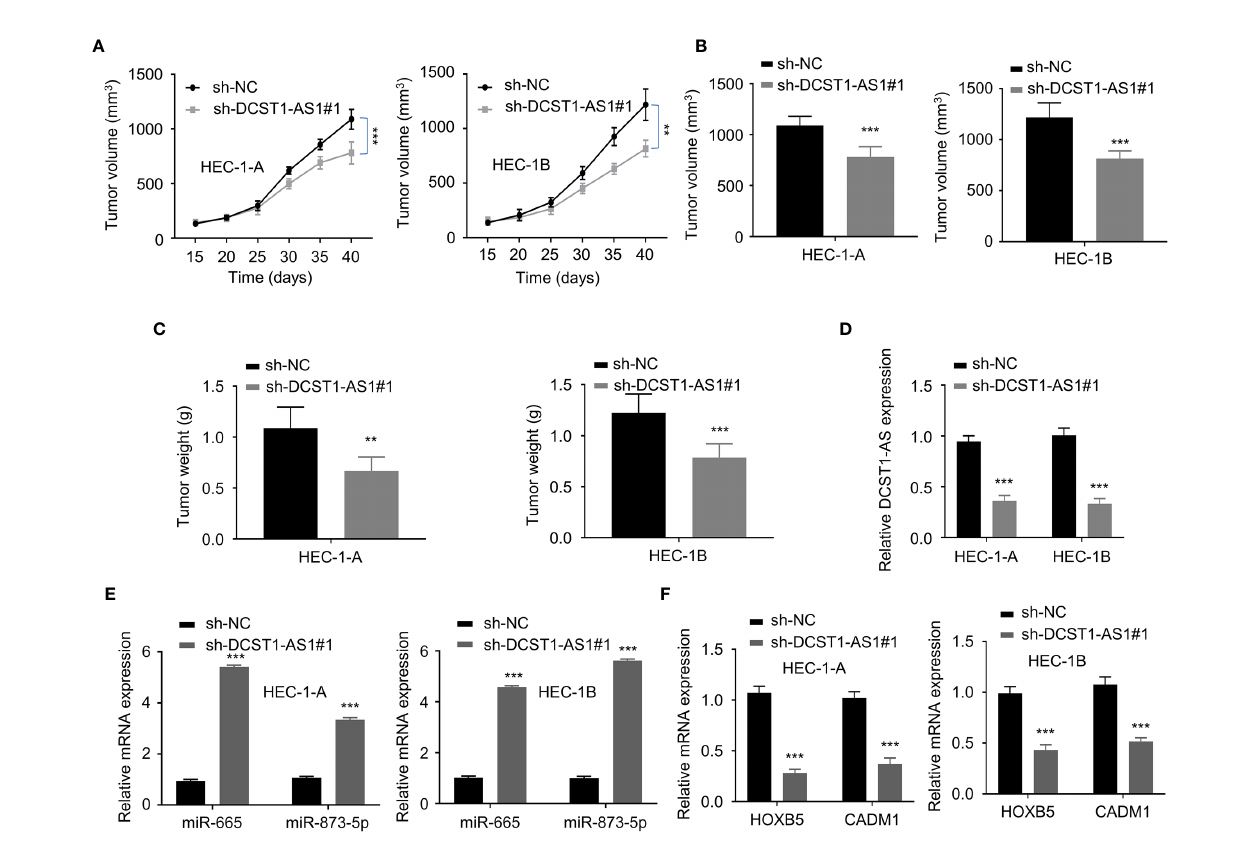
FIGURE 8 | LncRNA DCST1-AS1 promotes EC tumor growth in vivo . (A, B) The growth curves (A) and tumor volume (B) after injection of DCST1-AS1 shRNA#1 or control shRNA. (C) The weight of tumors. (D) The expression of DCST1-AS1 was detected in tumors from control shRNA or DCST1-AS1 shRNA#1 group mice by qRT-PCR assay. (E) The expression of miR-665 and miR-873-5p in tumor samples was detected by RT-qPCR assay. (F) The qRT-PCR assay of HOXB5 and CADM1 expression in tumor samples from different groups. ** P < 0.01, *** P <